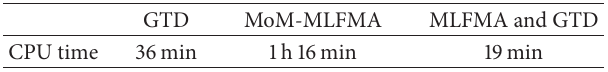
Table 1: Comparison of the CPU time for the analysis of the Hispasat test case.